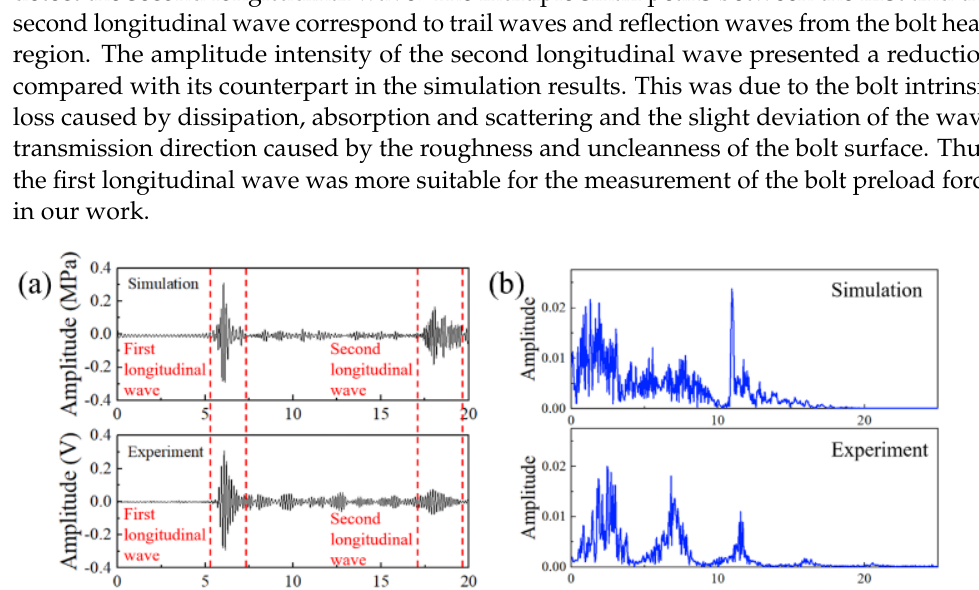
Figure 6. Ultrasonic longitudinal wave propagating along the axial direction in the bolt; dissemination process: ( a ) → ( b ) → ( c ) → ( d ).